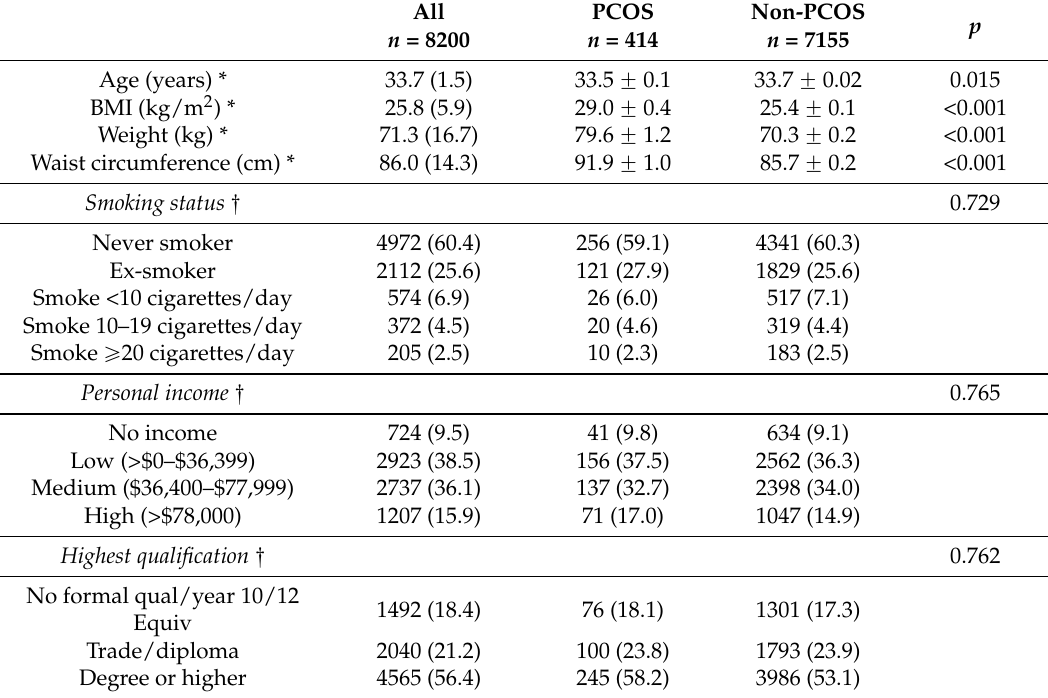
Table 1. Characteristics for women with and without polycystic ovary